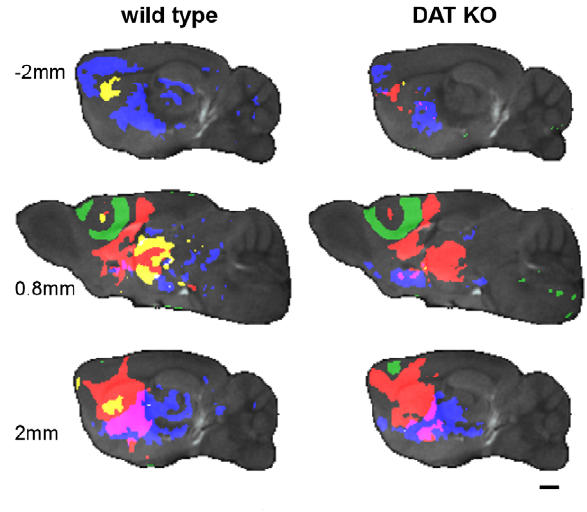
Figure 6. Transverse sections of statistical parametric maps show the progression of Mn 2 + accumulation over time. Representative transverse sections through the statistical parametric maps show the progression of Mn 2 + accumulation over time. Gray background is pre-injection MDT, while the green (1 hr . pre-injection), red (4 hr . 1 hr), yellow (8 hr . 4 hr) and blue (26 hr . 8 hr) overlays indicate areas with increased intensity (P , 0.00025) compared to the preceding time point. Videos in Supplemental Data show the complete image data sets for each genotype (Video S3). Slice locations are indicated relative to the brain. Scale bars =1